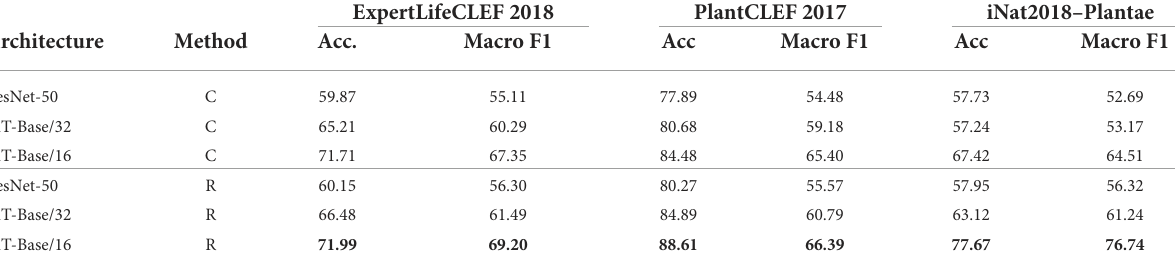
TABLE 4 Performance evaluation for Classification (C) and Retrieval (R) based